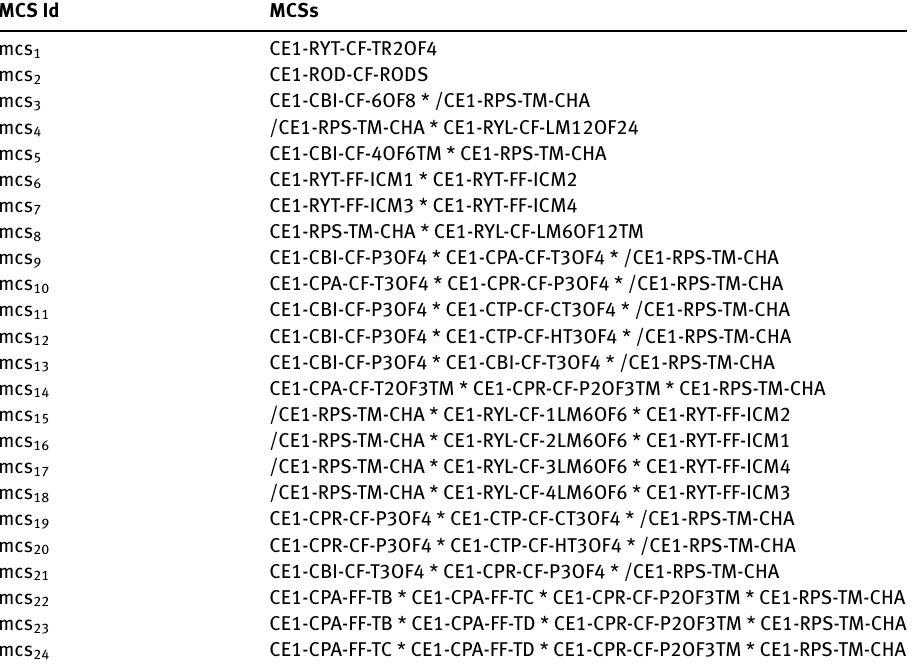
Table 2: The MCSs of the CERPS Group 1 Fault Tree [47].